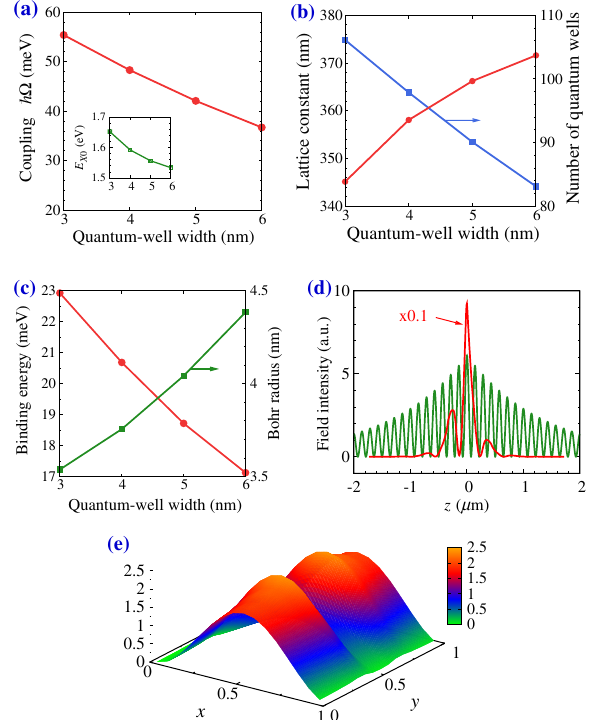
FIG. 3. Very strong light-matter interaction in the photonic band-gap 2D guided mode. (a) Exciton-photon collective inter- action strength ℏ Ω as a function of QW width for a fixed barrier width of 5 nm. The horizontal axis spans from N ¼ 106 to 83 QWs. Inset: Exciton-recombination energy E . The lowest 2D X 0 photonic band edge ℏ ω 0 is kept in resonance with the exciton- recombination energy E as the QW width is varied. The barrier X 0 layers between QWs are made of Cd 0 Mg 0 Te. (b) As E X 0 . 6 . 4 varies with the QW width, the photonic crystal lattice constant a is adjusted (red curve) to keep ℏ ω 0 ¼ E . Since a changes, the X 0 total number N of QWs (blue curve) in the slab and rods also changes. (c) Exciton-binding energy and Bohr radius for different QW widths calculated using an effective mass approximation [45] (see the Appendix). (d) Average electric field-intensity R d~ ρ j ~ E ð ~ ρ ; z Þj 2 profile at the 2D guided mode edge in S − 1 the PBG cavity (red curve) compared to that in the Cd 0 Mg 0 Te-Cd 0 Mn 0 Te Fabry-Pérot cavity [44] (green . 4 . 8 . 2 . 6 curve) along the z direction. The photons in both cavities have a band-edge energy of 1.59 eV. The photonic field intensity in the PBG cavity is multiplied by a factor of 0.1 in the figure. The Fabry-Pérot cavity is a λ = 2 cavity with λ ¼ 780 nm. The lattice constant of the photonic crystal is a ¼ 360 nm. (e) Field- intensity j ~ E j 2 profile in the x - y plane (in one unit cell of photonic crystal) at z ¼ 0 . Here, the averaged intensity is 1. The x and y coordinates are in units of the photonic lattice constant a